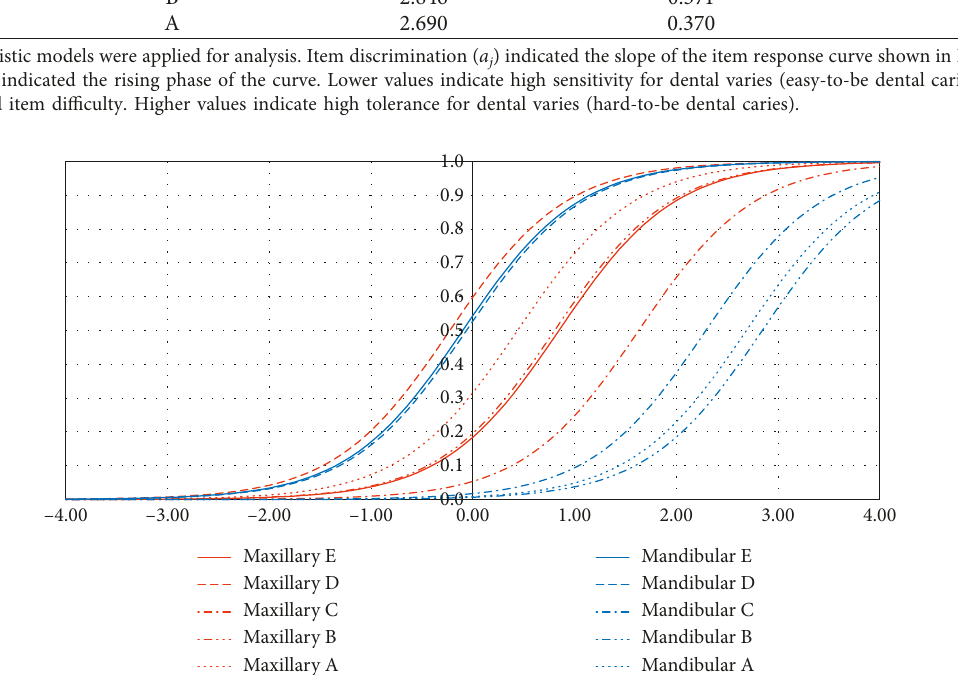
Figure 2: Item response curve of the sensitivity for dental caries of deciduous teeth. Horizontal axis indicates the total score of dental caries which is standardized as the def; 99% of def were transformed into − 4 to 4. Vertical axis indicates the percent of subjects with dental caries for each tooth. When the ability (total score of dental caries) is fixed, prevalence of dental caries can be estimated. The curve located left side indicated that the teeth are highly susceptible to dental caries. The curve located right side indicated that the teeth are highly tolerant to dental